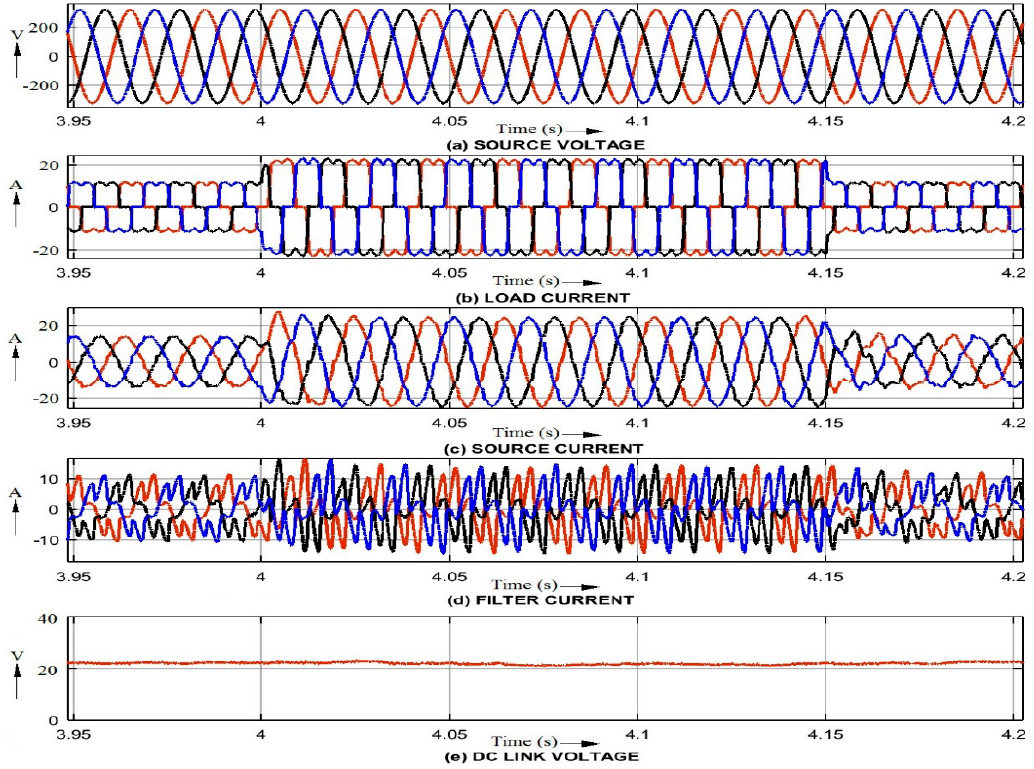
Figure 6. Response of the compensator to sudden change of load current.